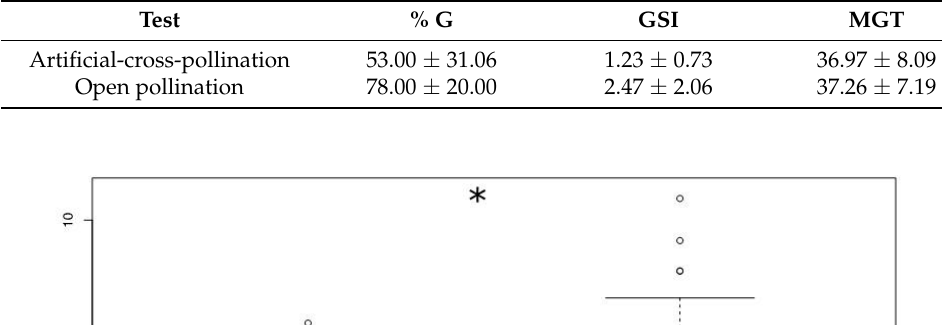
Table 3. Percent germination (%G), germination speed index (GSI) and mean germination time (MGT) of Ludwigia nervosa seeds obtained from pollination treatments.